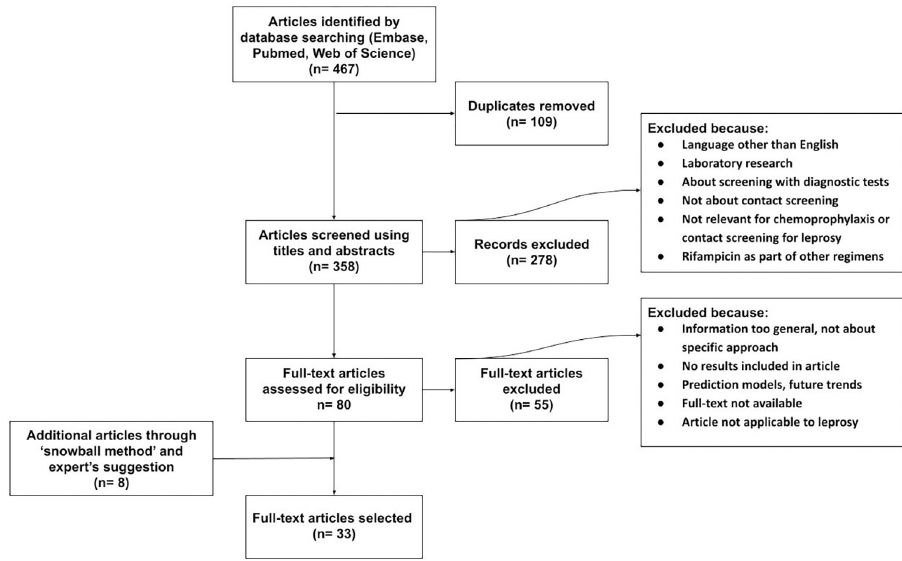
Fig 2. Prisma flowchart of search results for literature